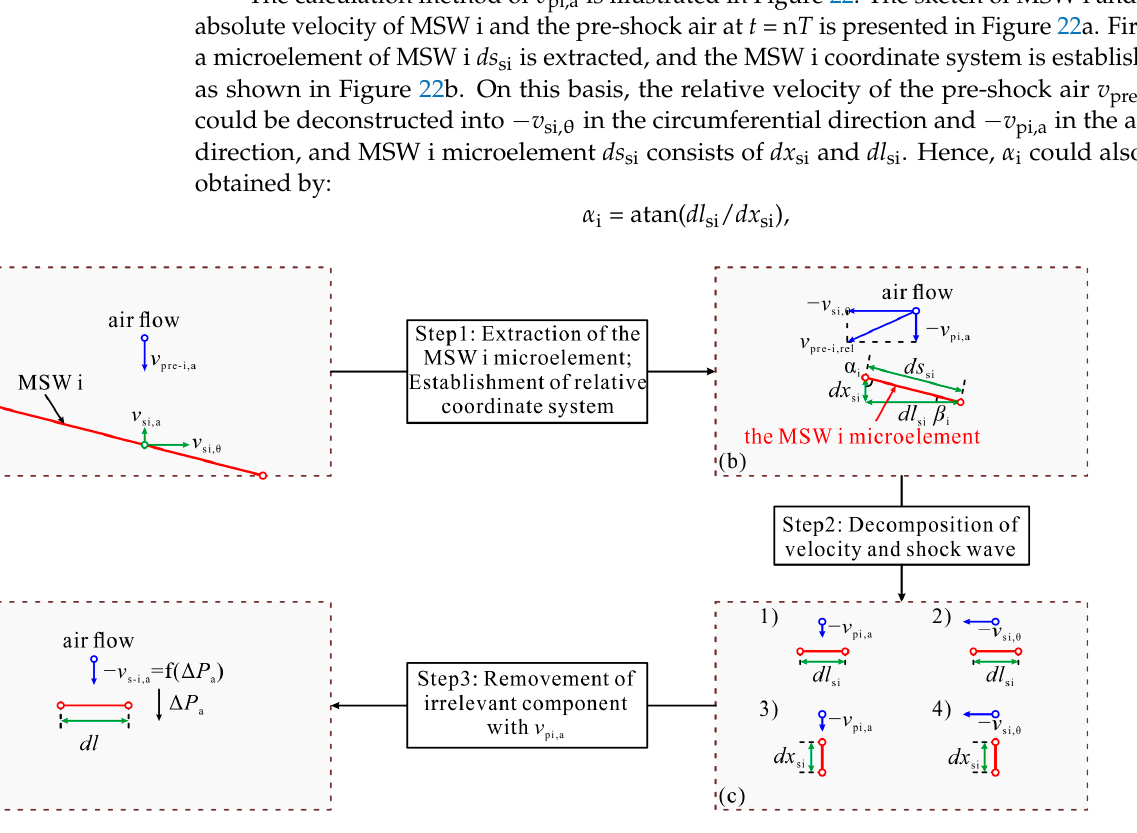
Table 4. Integral average results of the MSWs.